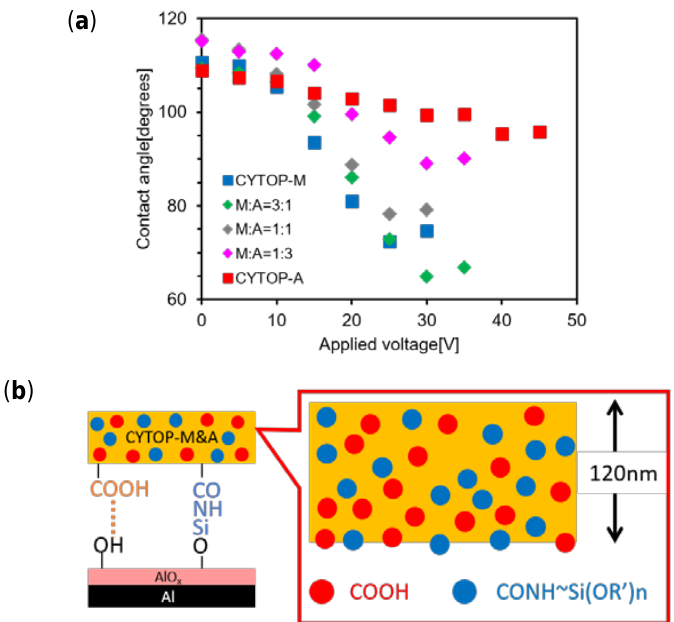
Figure 7. ( a ) Results of EWOD curve, with M:A = 3:1 (green), M:A = 1:1 (gray), and M:A = 1:3 (pink). Each sample had breakdown at 30 V or 35 V. All samples had a DC voltage applied, increasing the voltage in 5 V increments. ( b ) The model of the CYTOP ratio was M:A = 1:1. CYTOP-M and CYTOP-A are uniformly dispersed.